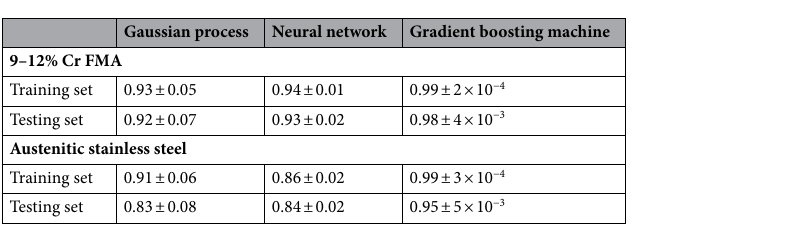
Table 2. Summary of the ML model results in terms of correlation coefficient ( R 2 ) for both the training and hold out testing set.